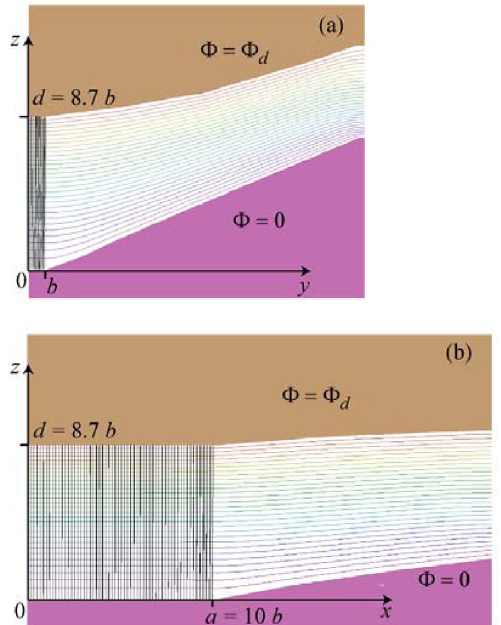
FIG. 4. (Color) A 3D OMNITRAK simulation of space-charge- limited Child-Langmuir flow using the 10:1:8.7 elliptical diode geometry shown in Fig. 3. Particle trajectories and equipotentials are shown in (a) the x (cid:7) 0 plane and (b) the y (cid:7) 0 plane.